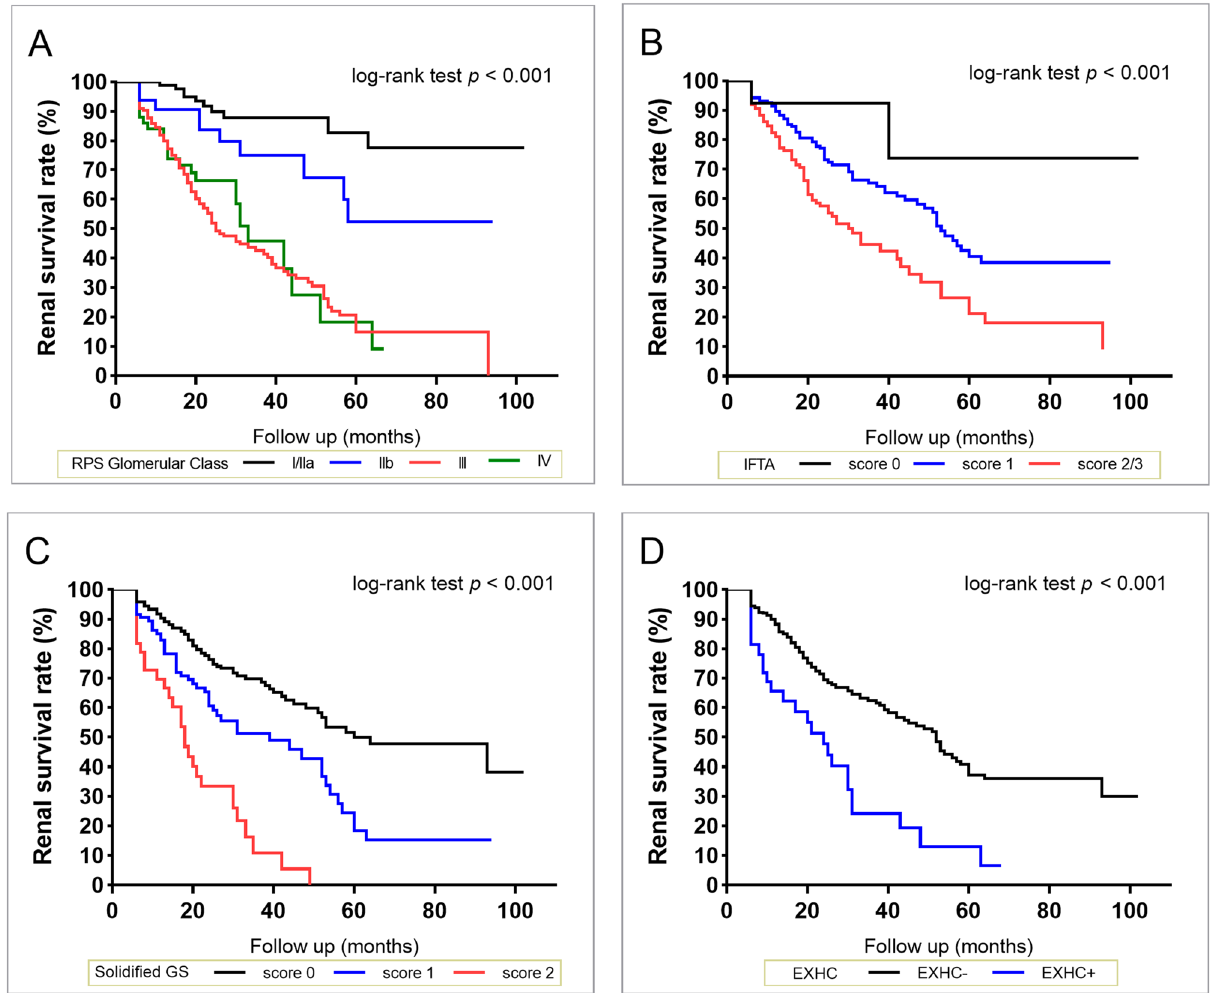
Figure 1. Kaplan–Meier survival curves for end-stage renal disease stratified by each pathological feature. ( A) Renal Pathology Society glomerular classification. ( B ) Interstitial fibrosis and tubular atrophy. ( C ) Solidified glomerulosclerosis. ( D ) Extracapillary hypercellularity. RPS, Renal Pathology Society; IFTA, interstitial fibrosis and tubular atrophy; GS, glomerulosclerosis; EXHC, extracapillary